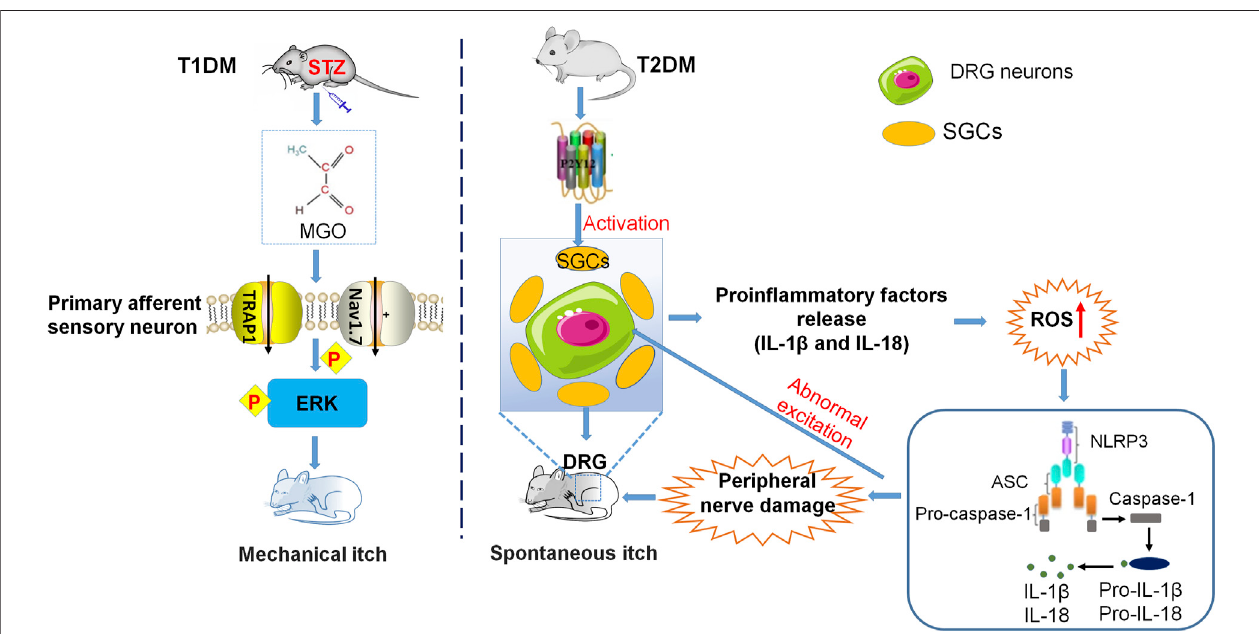
FIGURE3| Neuroin fl ammatorymechanismsunderlyingdiabetes-relatedchronicitch.ThemechanicalitchinducedbyMGOorintheSTZ-inducedmousemodelof T1DMismediatedbyactivationofTRPA1,Nav1.7,andERKintheDRGneurons.IntheT2DMmousemodel,theupregulationofP2Y12expressioninSGCscontributes to the increase of ROS, followed by the activation of NLRP3 in fl ammasome, the upregulation of in fl ammatory cytokines, and the damage to peripheral nerves. These changes fi nally result in DRG neuron hyperexcitability and sensitization.